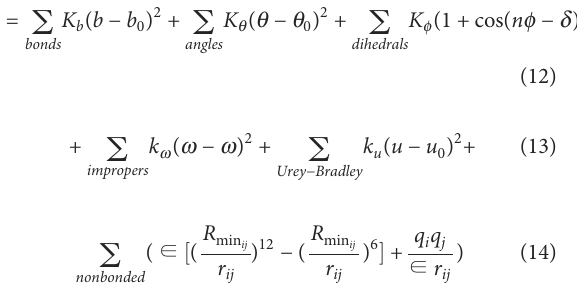
Equation 3. CHARMM force fi eld formula adapted from Mackerell et al. for electrical potential across protein